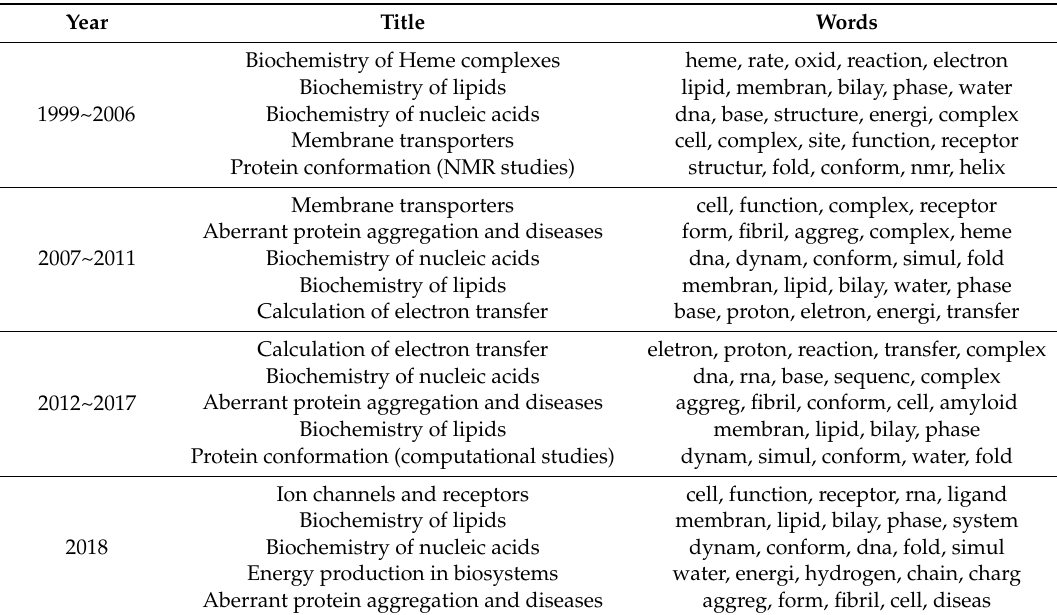
Table 5. Topics and Words by